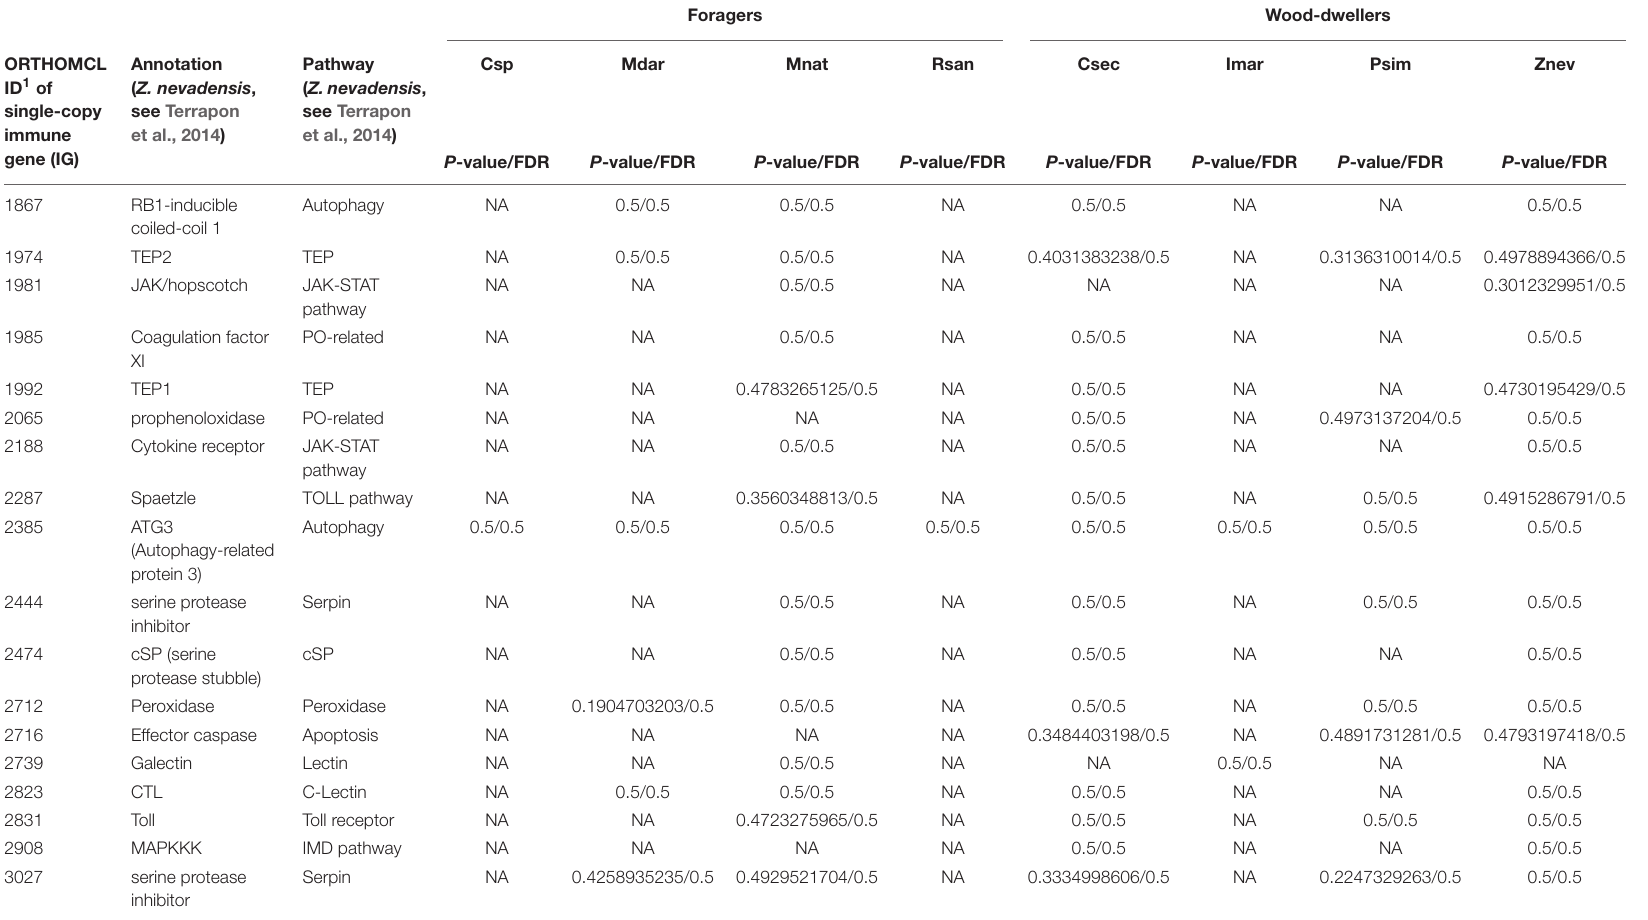
TABLE 2 | Summarized results of BUSTED analyses of single-copy IGs for each termite species tested against all other species in the alignment. Foragers